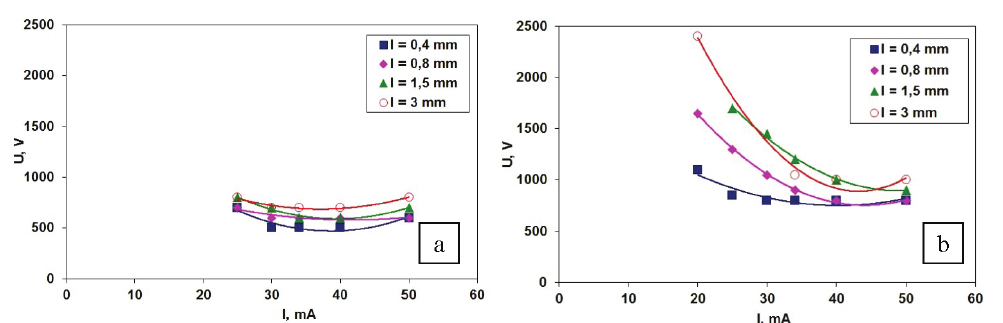
Figure 3: The CVC of the microdischarge with vortex gas flow for different interelectrode gaps and polarity of the flat electrode: а) positive; b) negative. Flat electrode has a gas outlet of 1.7 mm diameter, airflow is G = 4 L min -1